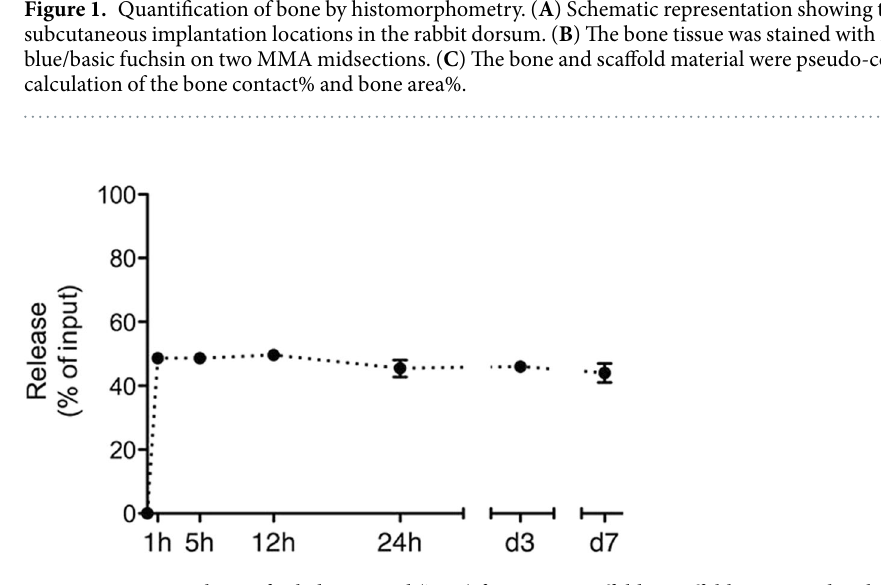
Figure 2. In vitro release of zoledronic acid (ZOL) from BCP scaffolds. Scaffolds precoated with 25 μ g ZOL were incubated in MilliQ at 37 °C. The released amount of ZOL was measured in the supernatant at the indicated time points and normalized to the input. The values represent the mean ± SD for duplicate